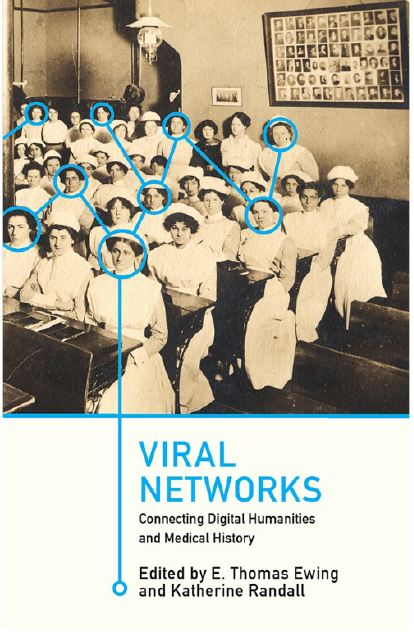
Figure 3 Cover of Viral Networks: Connecting Digital Humanities and Medical